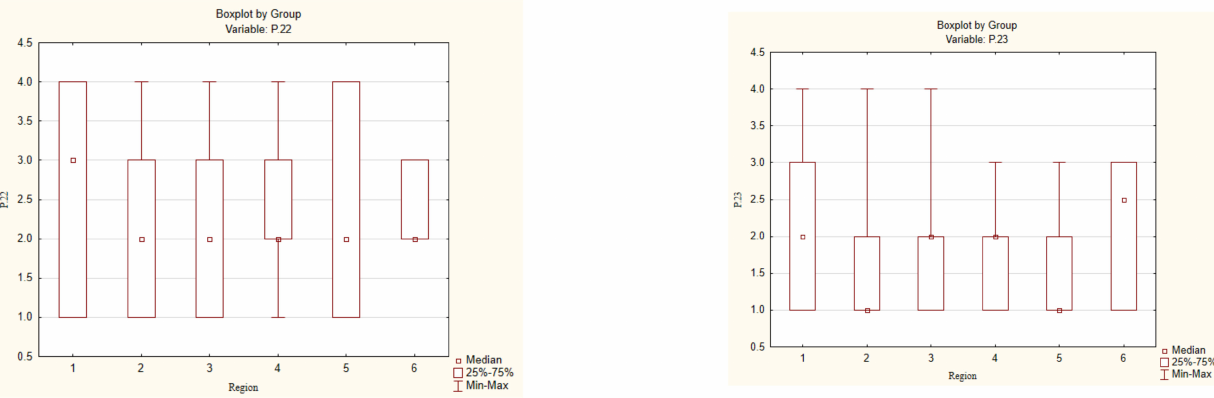
Figure 9. Box and whisker diagrams for practices P22 (Following garbage rules) and P23 (Garbage separation), the category “Waste